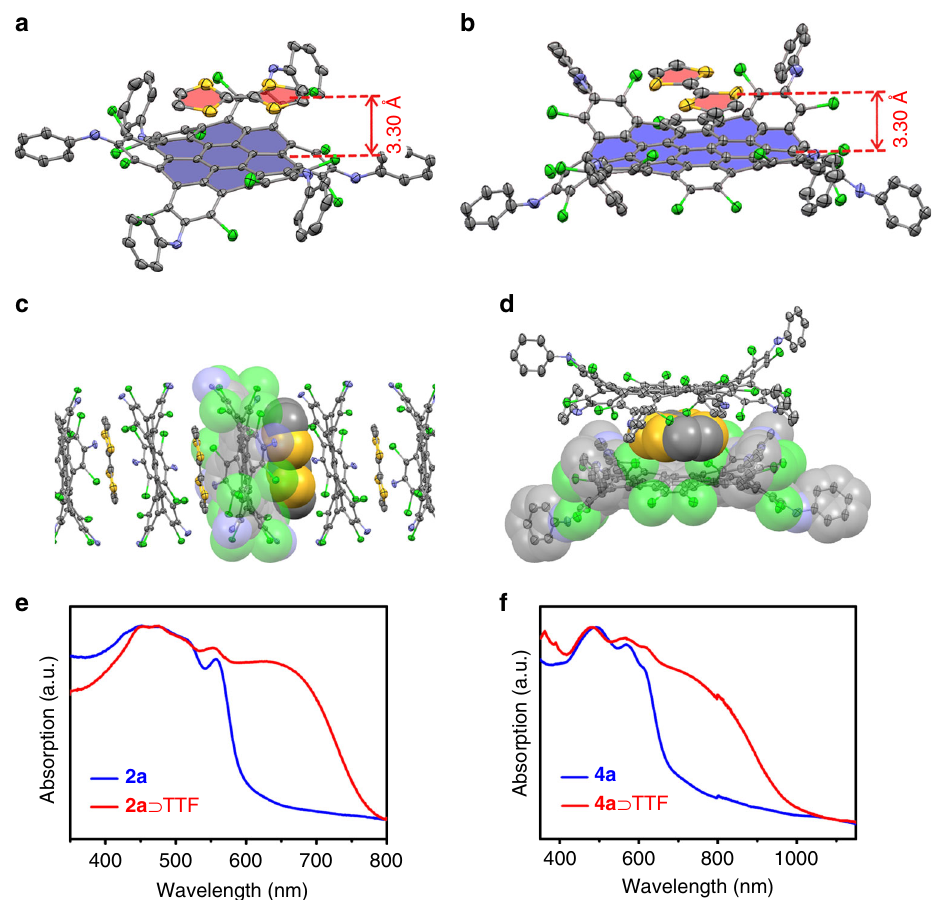
Fig. 5 Supramolecular assembly between D-A NGs and TTF. a , b the structures of 2a ⊃ TTF and 4a ⊃ TTF. c one dimensional mixed-stacking of 2a and TTF in the crystal. Peripheral phenyl groups were omitted for clarity. d sandwich-type complex of 2· 4a ⊃ TTF. e , f UV-Vis-NIR spectra of 2a , 2a ⊃ TTF, 4a and 2· 4a ⊃ TTF in the solid state measured in a diffuse-re fl ectance mode. CT bands at 650 nm and 780 nm were clearly observed in the spectra of supramolecular